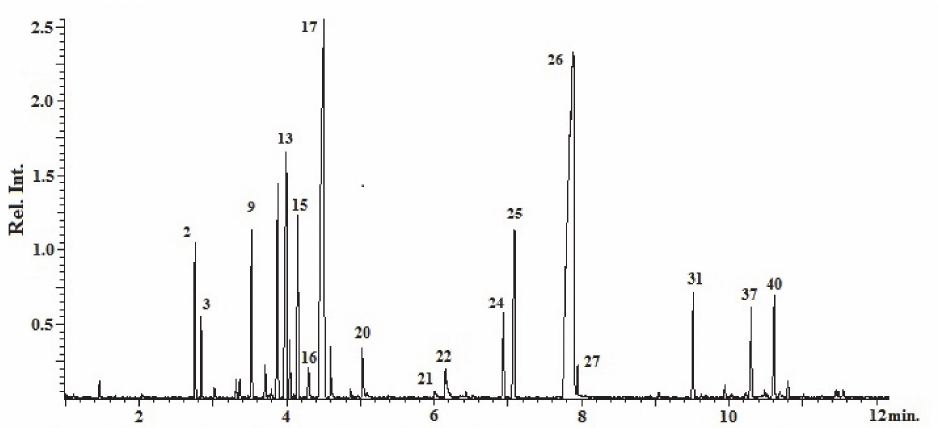
Figure 2. An example chromatogram of the EO from Origanum heracleoticum grown in Sicily. Peaks numbers correspond to the compounds listed in Table 1.